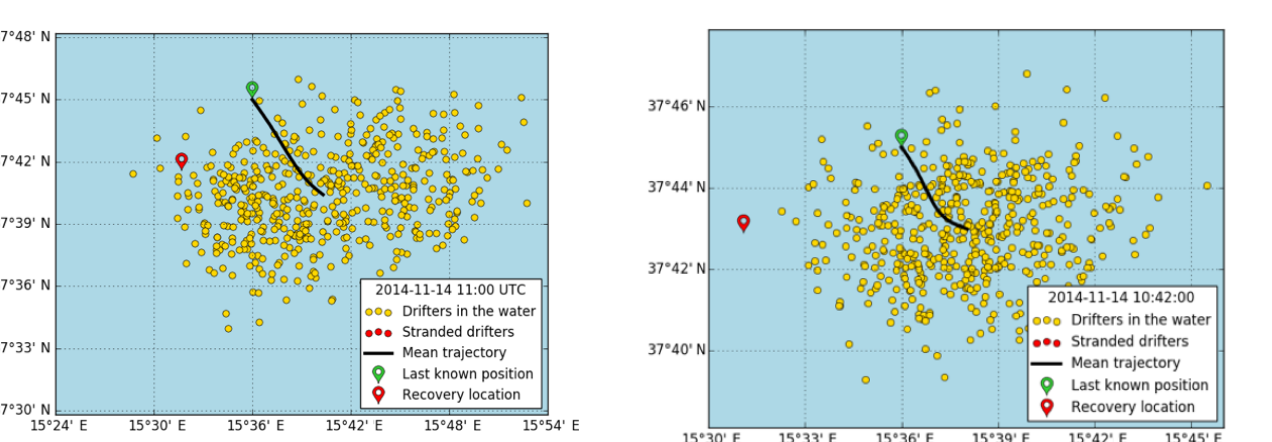
Figure 11. Results of the “Calabria2” simulation done using OCEAN-SAR showing the positions (yellow points) of the particles at the end of the simulation 10:40UTC of 14 November 2014. The red place marker indicates the position in which the raft was col- lected. The green place marker represent the position in which the dummy was launch at sea and start drifting. The black line shows the mean trajectory of the launched particles. During the exercise the wind speed ranged from approximately 3 to 10ms − 1 , predom- inantly in the south-south-west